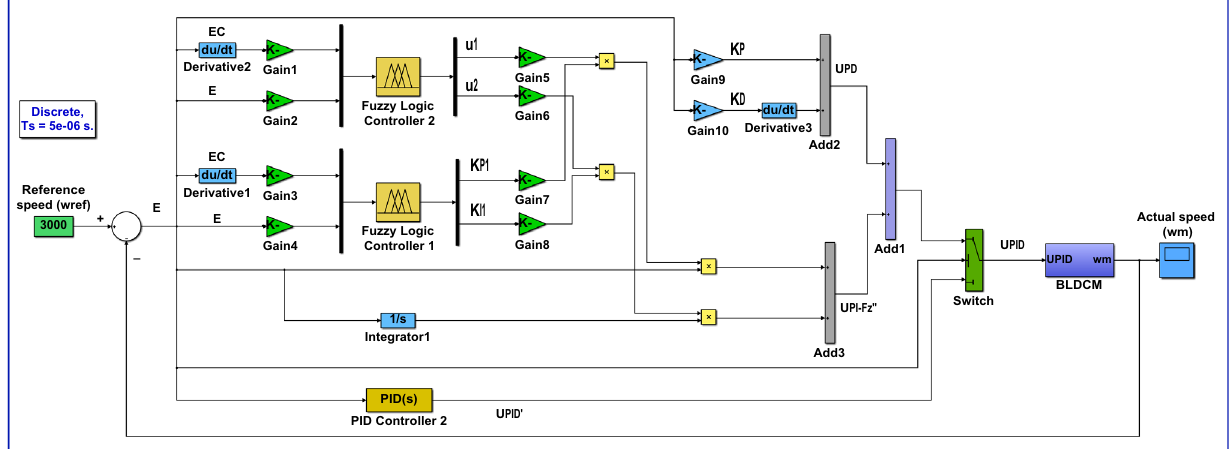
Fig. 5 The structure of a BLDCM speed current control